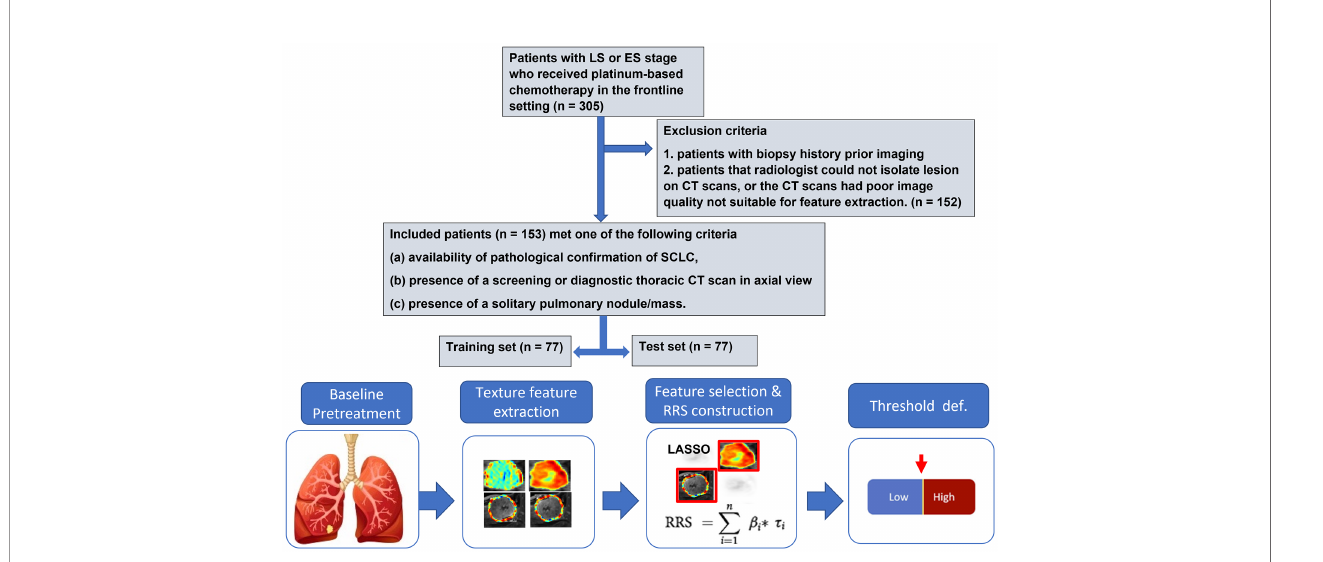
FIGURE 1 | Patient selection and overall experimental design for this